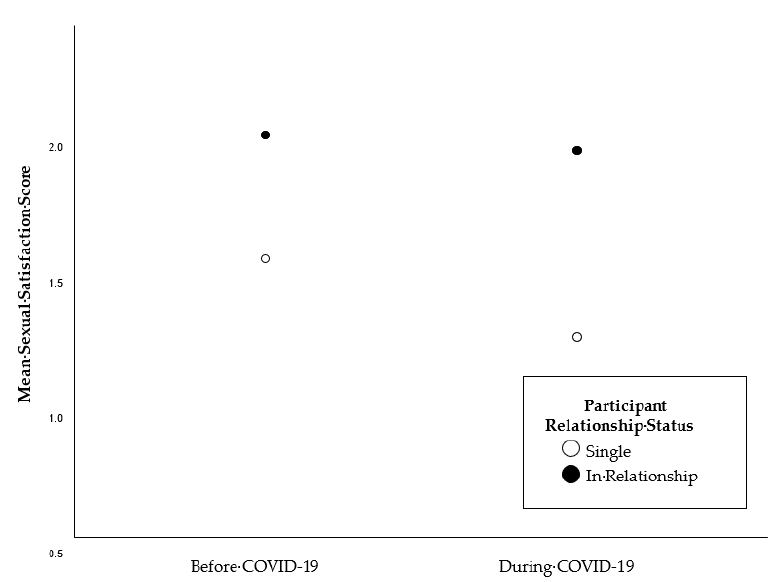
Figure 1. Mean sexual satisfaction scores before and during COVID-19 social distancing measures, by participant relationship